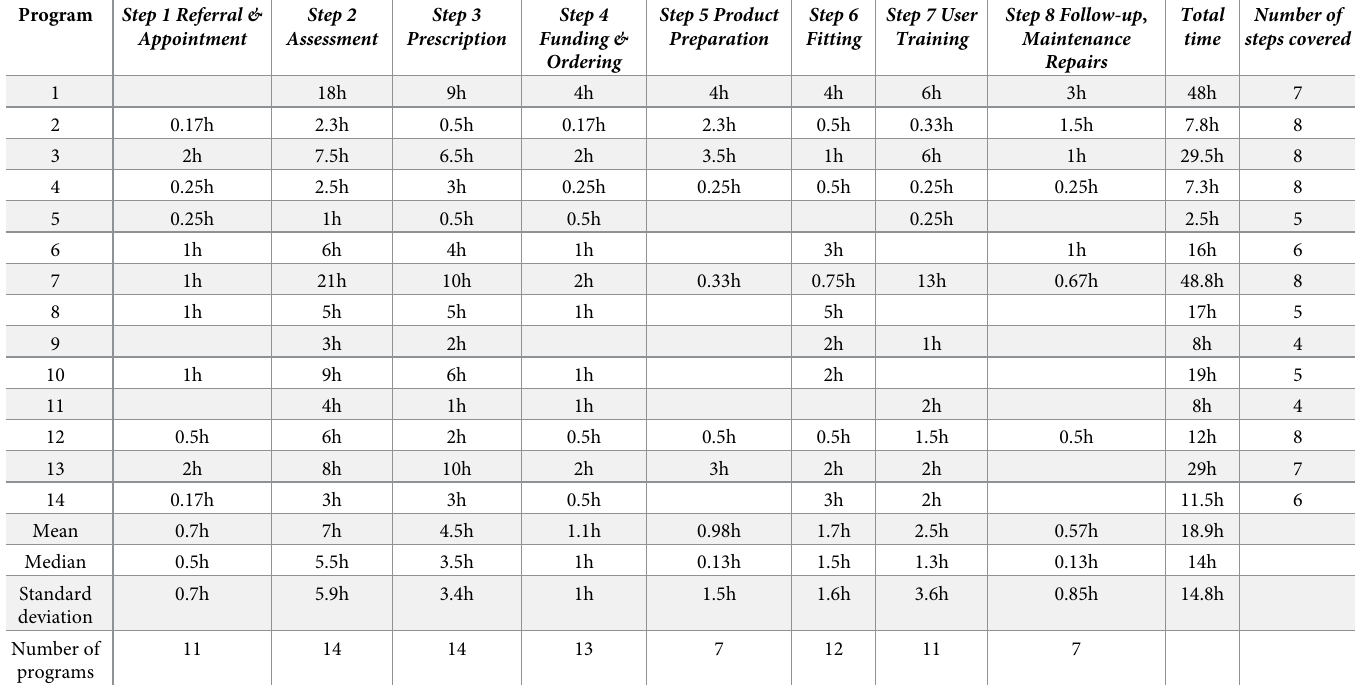
Table 2. Time allotted to teaching each of the WHO wheelchair service provision steps by program.